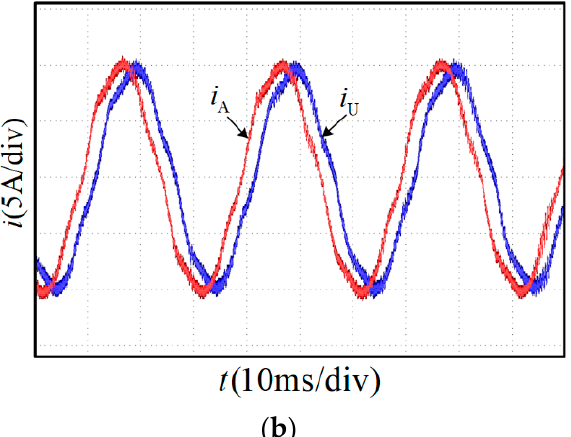
Figure 10. Comparison of current waveforms between two MPC control modes.( a ) traditional MPC; ( b ) Dual second-order MPC.